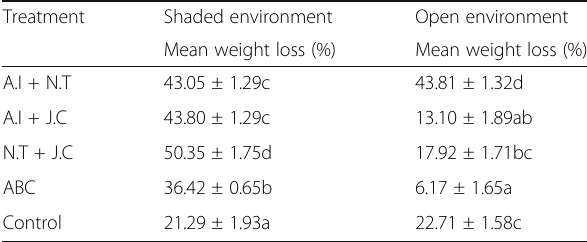
Table 1 Percentage weight loss (Mean ± S.E) in extract-treated wood exposed to subterranean termites under shade and in the open field Treatment Shaded